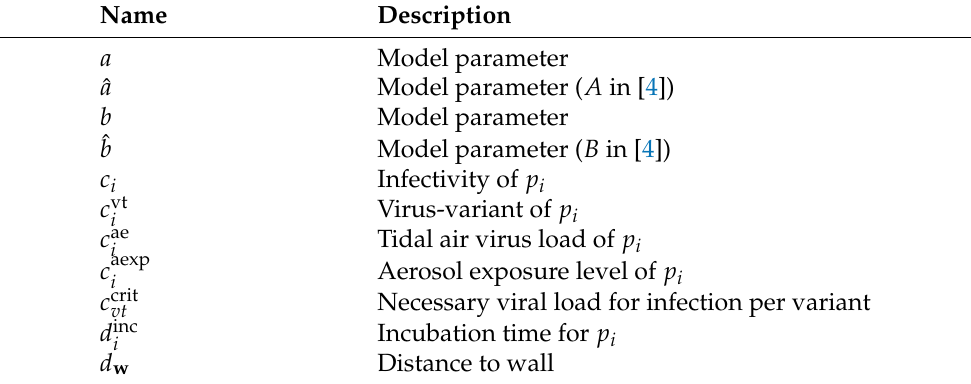
Table 1. List of identifiers and parameters